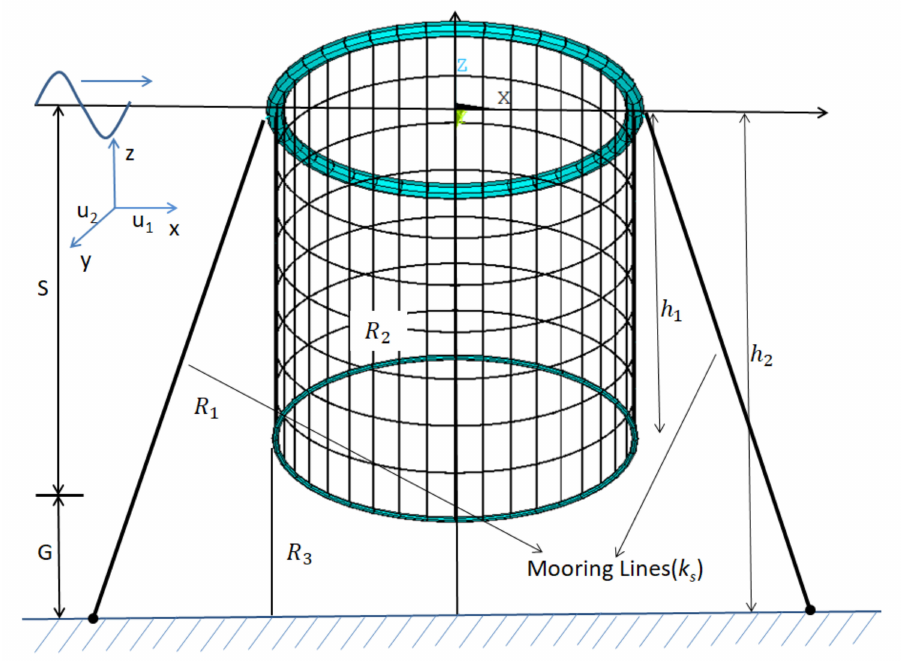
Figure 1. Moored (stiffness k s ) flexible cylindrical net cage under a uniform current u (= u 1 = u 2 )